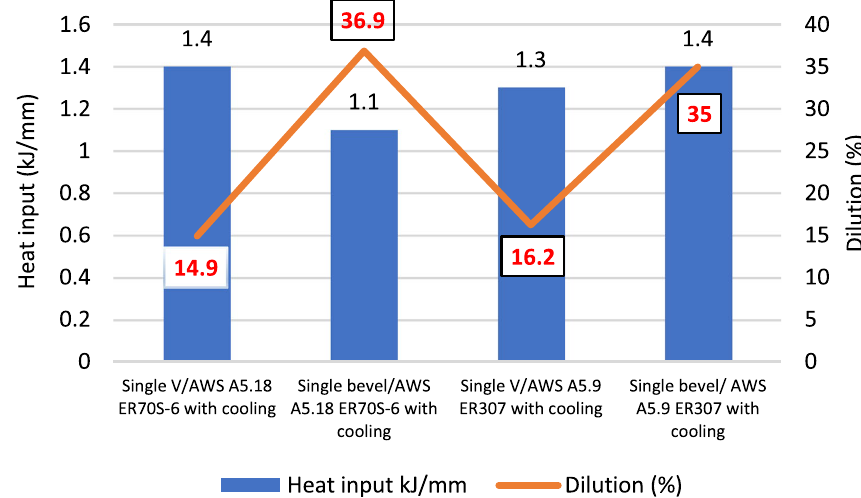
Fig. 10 Effect of joint configuration, heat input, and weld metals on dilution using GTAW